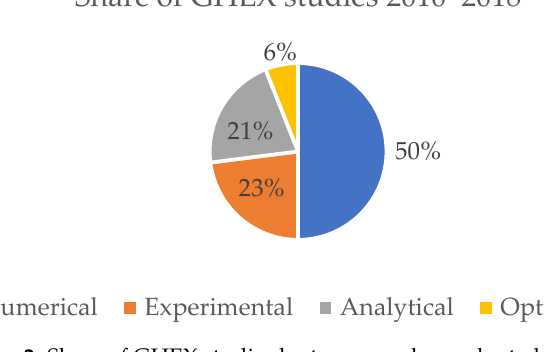
Table 1. Shallow heat exchanger types. Vertical Spiral/Helix [9]